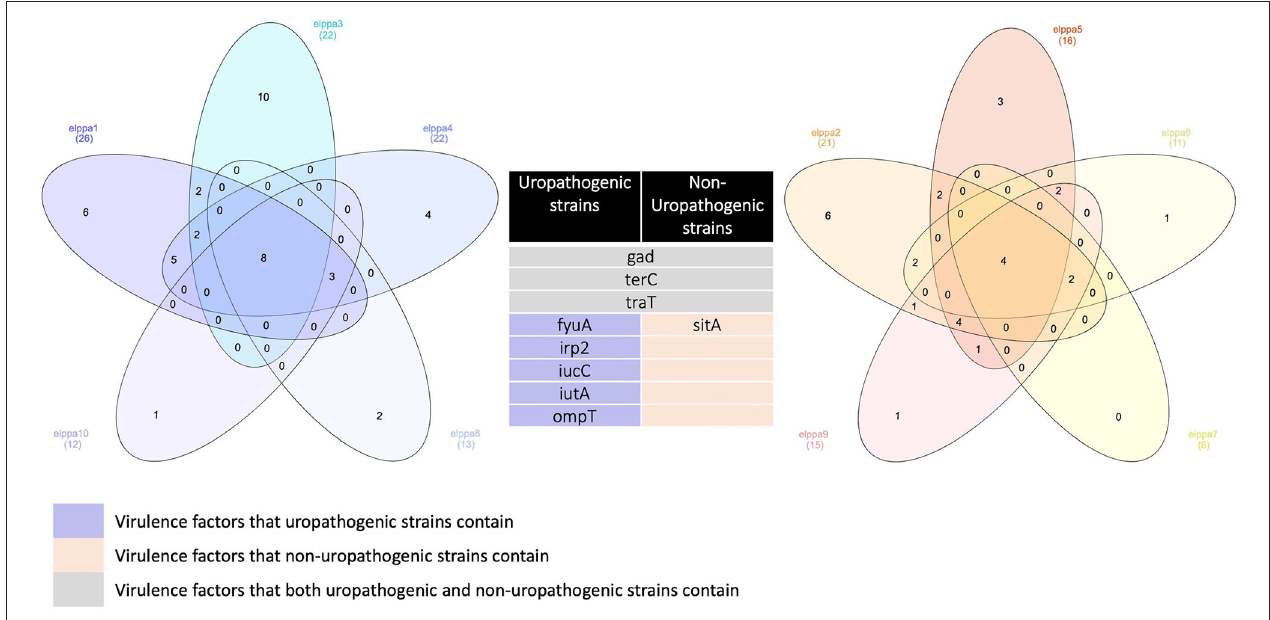
FIGURE 2 | Venn diagrams comparing virulence factors of bloodstream infections from abdominal origin or urologic origin. Five E. coli isolates from the urinary tract shared eight virulence factors, including gad, terC, traT, fyuA, irp2, iucC, iutA, and ompT . Five E. coli isolates from abdominal origin shared four virulence factors, including gad, terC, traT, and sitA . Bloodstream infection from both sources contained virulence factors of gad, terC, and traT. Venn diagrams were created by InteractiVenn (Heberle et al.,